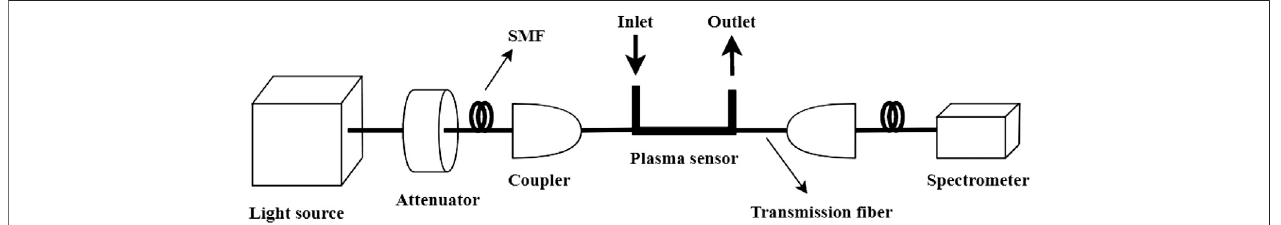
FIGURE 11 | Diagram of system device used for chemical solution concentration